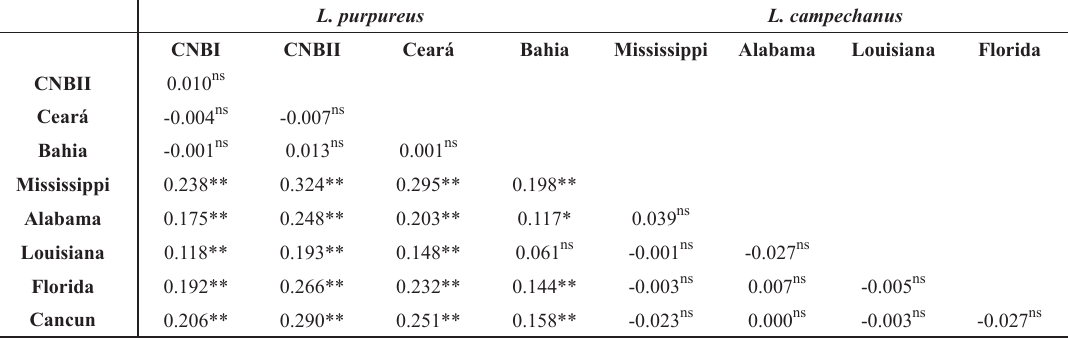
Matrix of Fst values for pairwise comparisons between populations of L. purpureus and L. campechanus from the western Atlantic. Significance level: ns: not significant; * = P < 0.05; ** = P <